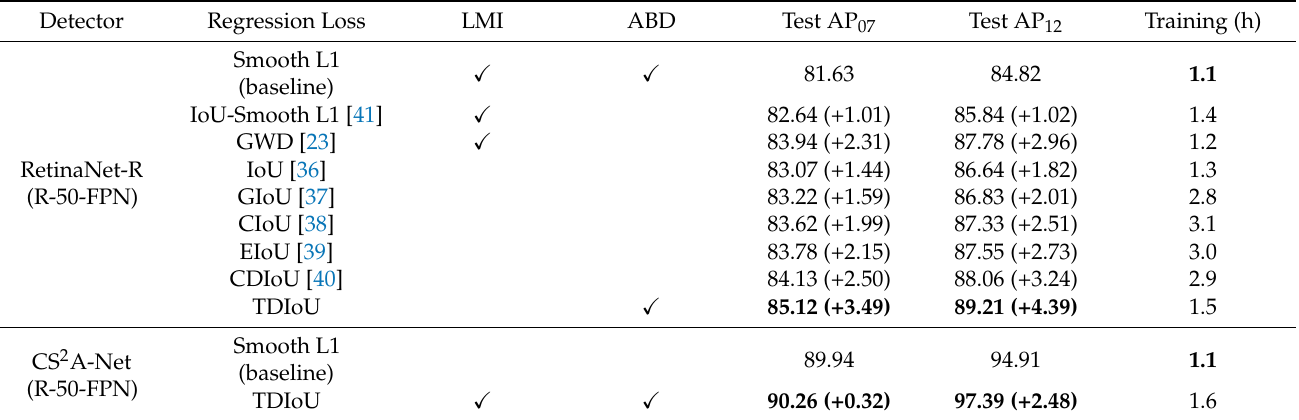
Table 6. Comparison of different regression losses on HRSC2016. Here, AP 07 and AP 12 indicate the PASCAL VOC 2007 and 2012 metrics,